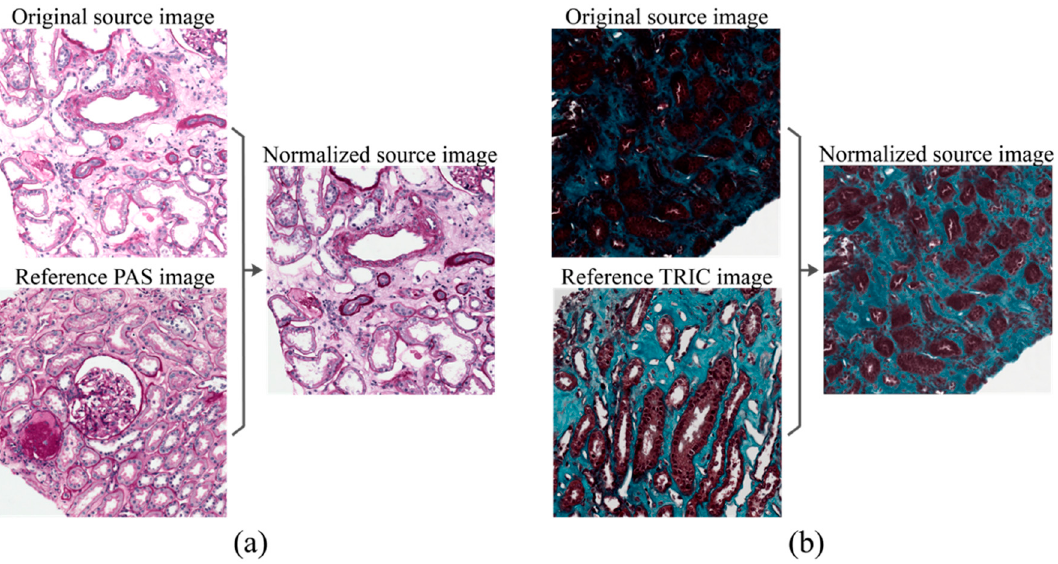
Figure 3. Stain normalization performed by the RENFAST algorithm. ( a ) PAS normalization; ( b ) TRIC normalization.